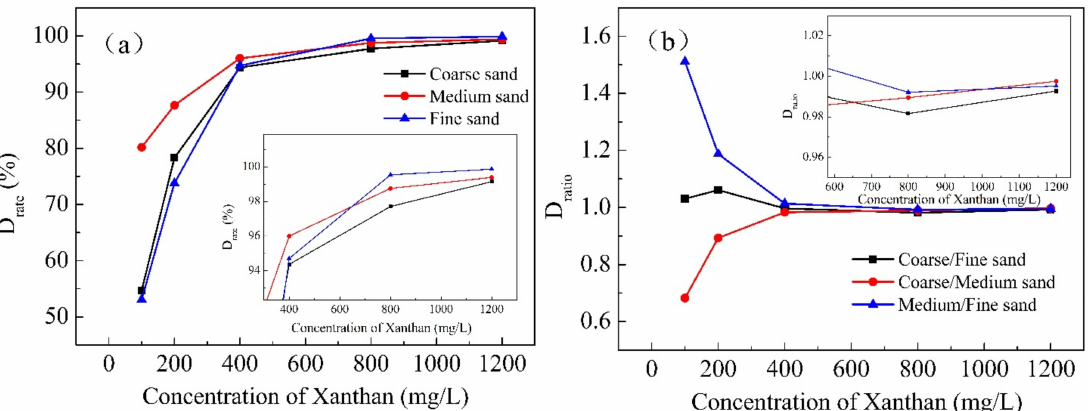
Figure 8. Hydraulic conductivity decrease rate and hydraulic conductivity decrease ratio vs. xanthan gum concentration. ( a ) D rate of each media, ( b ) D ratio of each